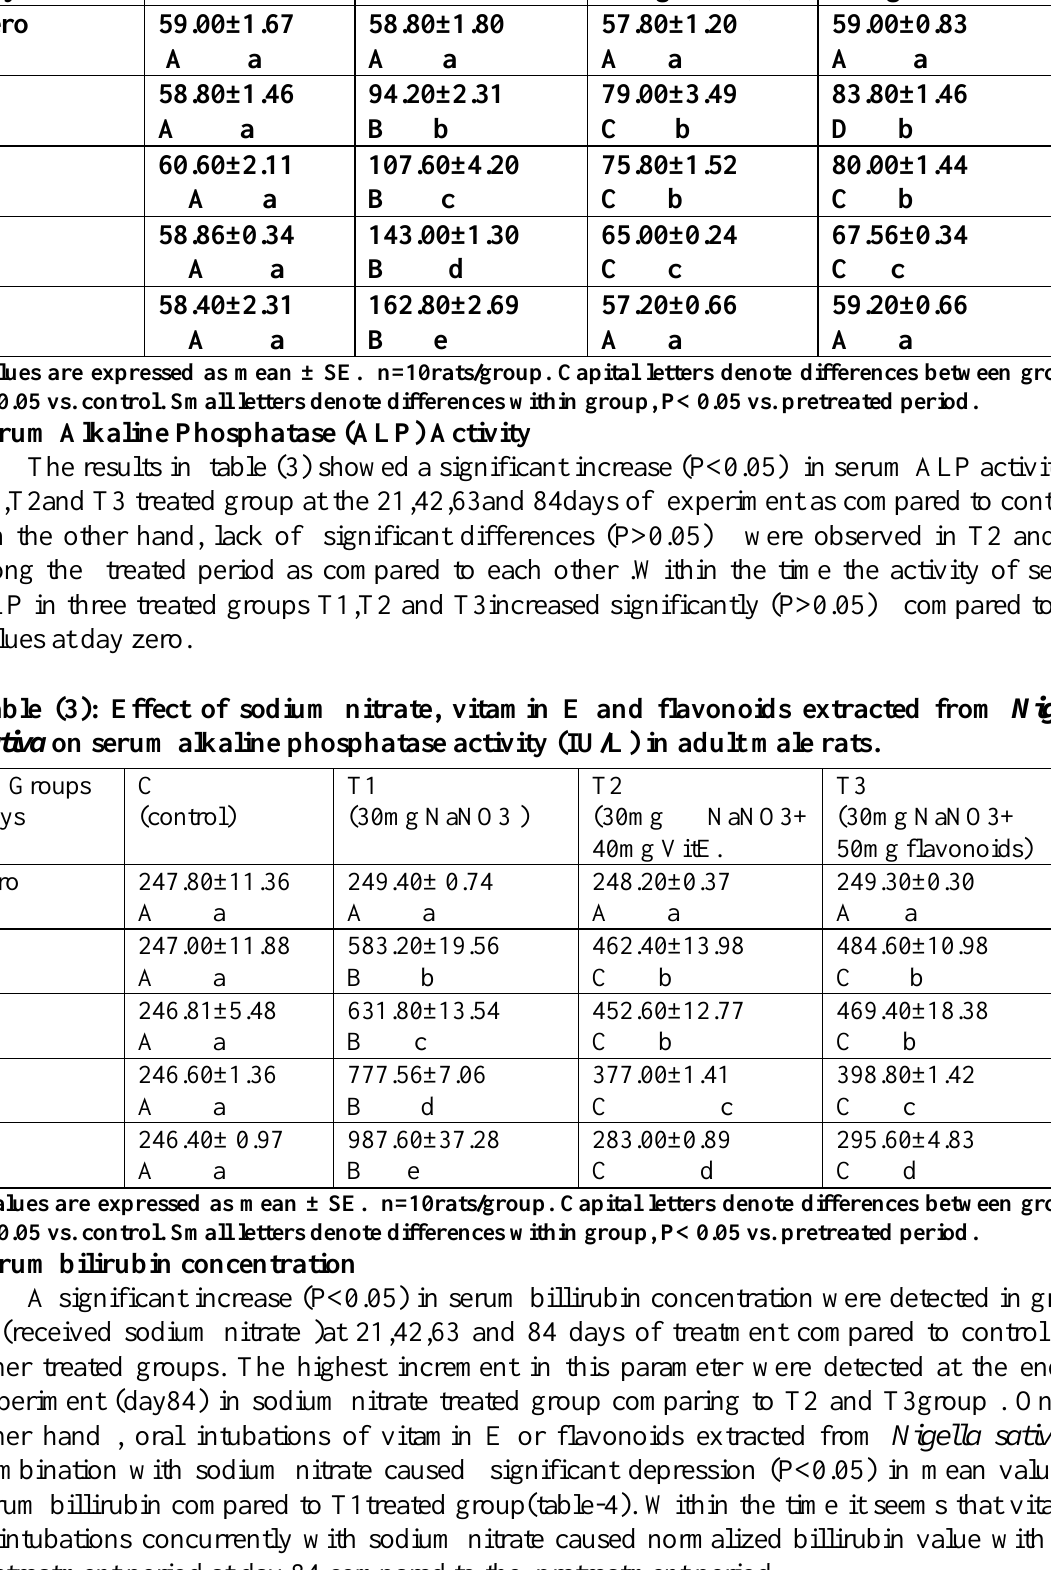
Values are expressed as mean ± SE. n=10rats/group. Capital letters denote differences between groups, P<0.05 vs. control. Small letters denote differences within group, P< 0.05 vs. pretreated